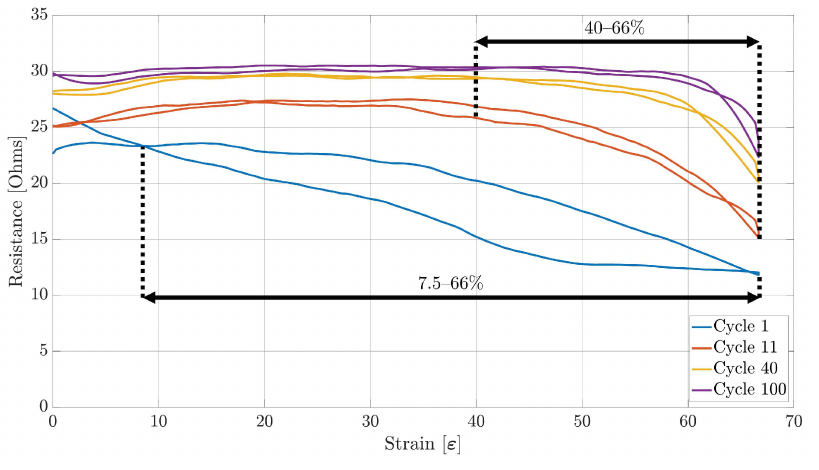
Figure 9. Sensor S1 strain data over the 1st, 11th, 40th, and 100th stretching cycle.